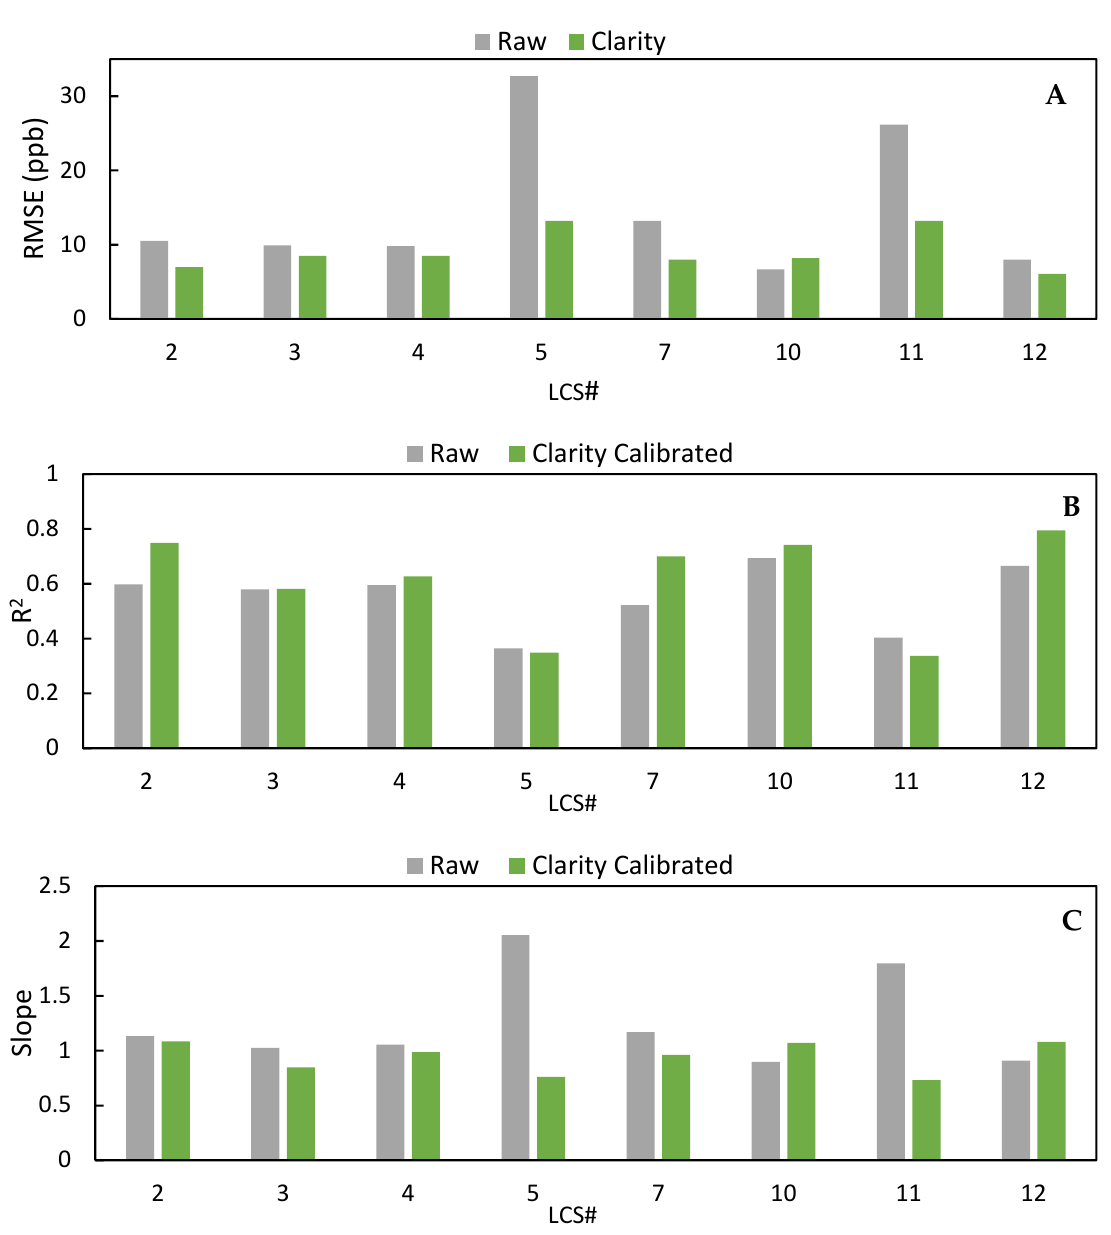
Figure 8. ( A ) A comparison of the RMSE values (ppb) between the raw and Clarity 15-day calibrated data. ( B ) A comparison of the R2 values between the raw and Clarity 15-day calibrated data. ( C ) A comparison of the slopes between the raw and Clarity 15-day calibrated data.